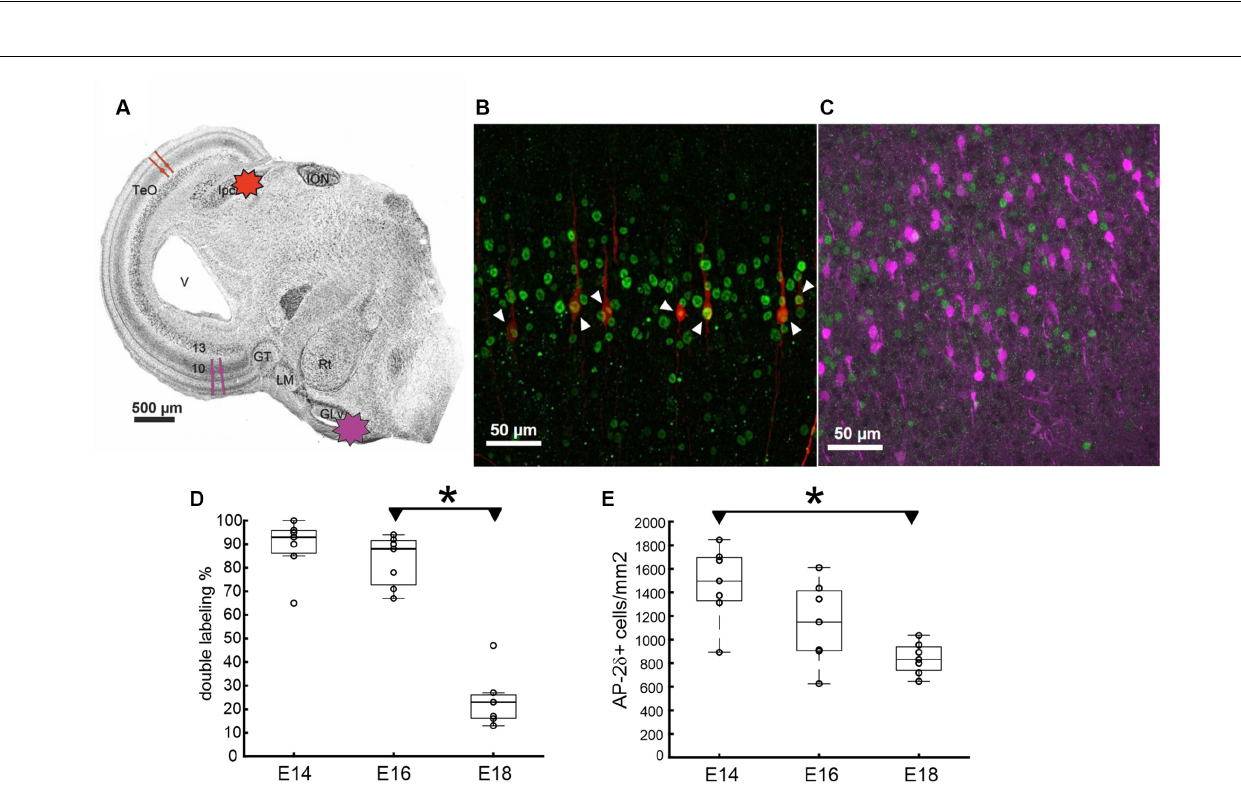
Frontiers in Neural Circuits |